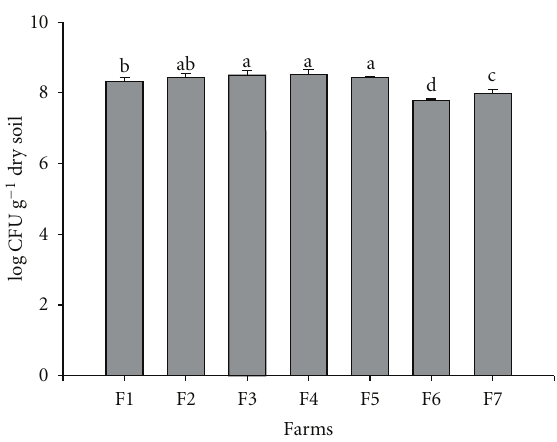
Figure 4: Nitrogenase activity. The bars correspond to average enzymatic activity, expressed in n moles of ethylene per gram of dry soil during 24 hours. Values shown with the same letter were not significantly di ff erent according to Tukey’s test, P = 0 . 05 sig- nificance level. The error bars correspond to standard deviation bars for each data